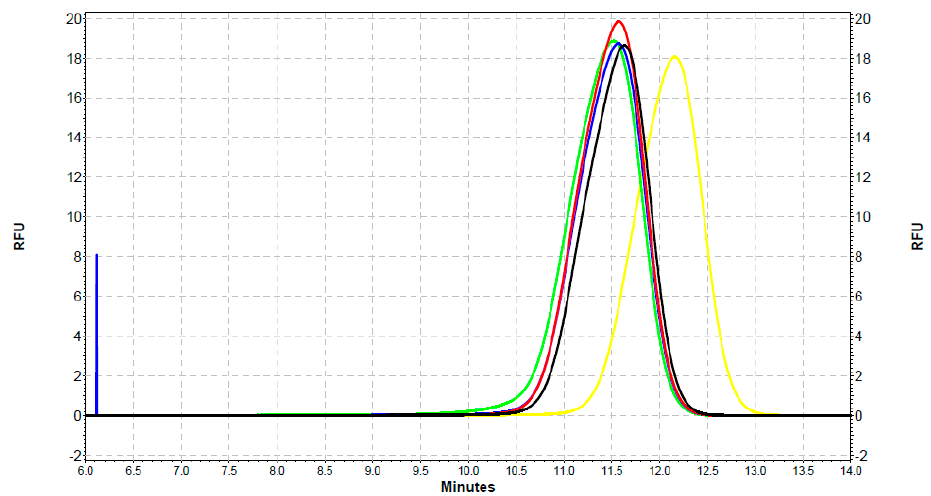
Figure 8. An electrophoretic diagram of the separation of Y-QDs–SOD complexes using CE with an LIF detector. Color codes: black: Y-QDs with SOD (1.2 µg/mL), red: Y-QDs with SOD (4 µg/mL), blue: Y-QDs with SOD (40 µg/mL), green: Y-QDs with SOD (400 µg/mL), and yellow: Y-QDs alone.